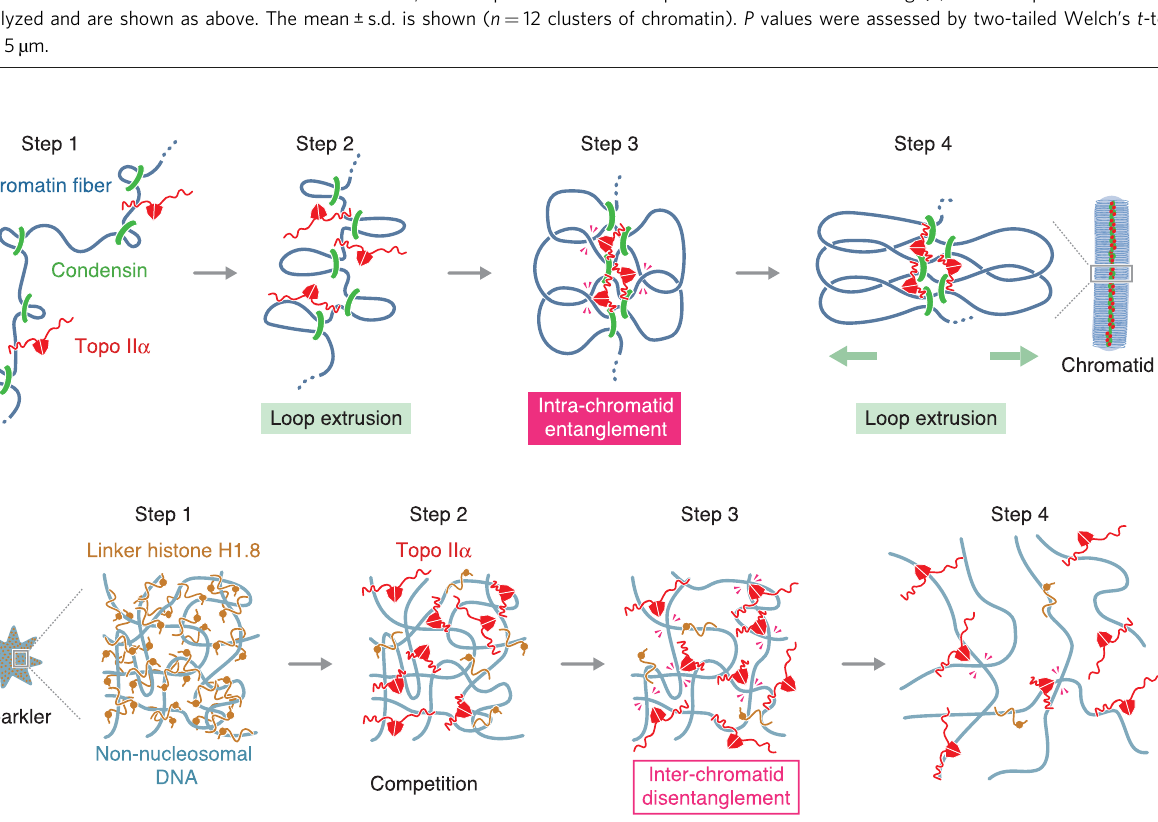
Fig. 5 Topo II α -FL, but not topo II α - Δ CTD, can ef fi ciently rescue the defects observed in the extracts depleted of both topo II α and Asf1. a , b Mouse sperm nuclei were incubated in a control extract ( Δ mock) or an extract depleted of either topo II α ( Δ topo II α ), Asf1 ( Δ Asf1), or both ( Δ topo II α Δ Asf1). After a 150-min incubation at 22 °C, the resultant structures were labeled with antibodies against the linker histone H1.8 and CAP-G. DNA was counterstained with DAPI. This experiment was repeated three times with similar results ( a ). Blow-up images of the cropped part (indicated by the dashed rectangle in the original DAPI image in a Δ topo II α Δ Asf1 extract) are shown in grayscale (DAPI) and pseudo-colors (merged images for the indicated combinations) ( b ) c , d An extract depleted of topo II α and Asf1 ( Δ topo II α Δ Asf1) was supplemented with either buffer, topo II α -FL, or topo II α - Δ CTD. After a 30-min incubation at 22 °C, mouse sperm nuclei were added to these extracts and incubated for another 150 min. The resultant chromatin structures were fi xed and processed for immunolabeling with the antibodies indicated ( c ). The compaction indices were analyzed and are shown in Fig. 4b. The mean ± s.d. is shown ( n = 12 clusters of chromatin). P values were assessed by two-tailed Welch ’ s t -test ( d ). e , f Mouse sperm nuclei were fi rst incubated in a Δ topo II α Δ Asf1 extract to allow sparkler formation. At 150 min, the reaction mixtures were supplemented with either buffer, topo II α -FL, or topo II α - Δ CTD. After another 150-min incubation at 22 °C, the samples were fi xed and processed for immunolabeling ( e ). The compaction indices were analyzed and are shown as above. The mean ± s.d. is shown ( n = 12 clusters of chromatin). P values were assessed by two-tailed Welch ’ s t -test